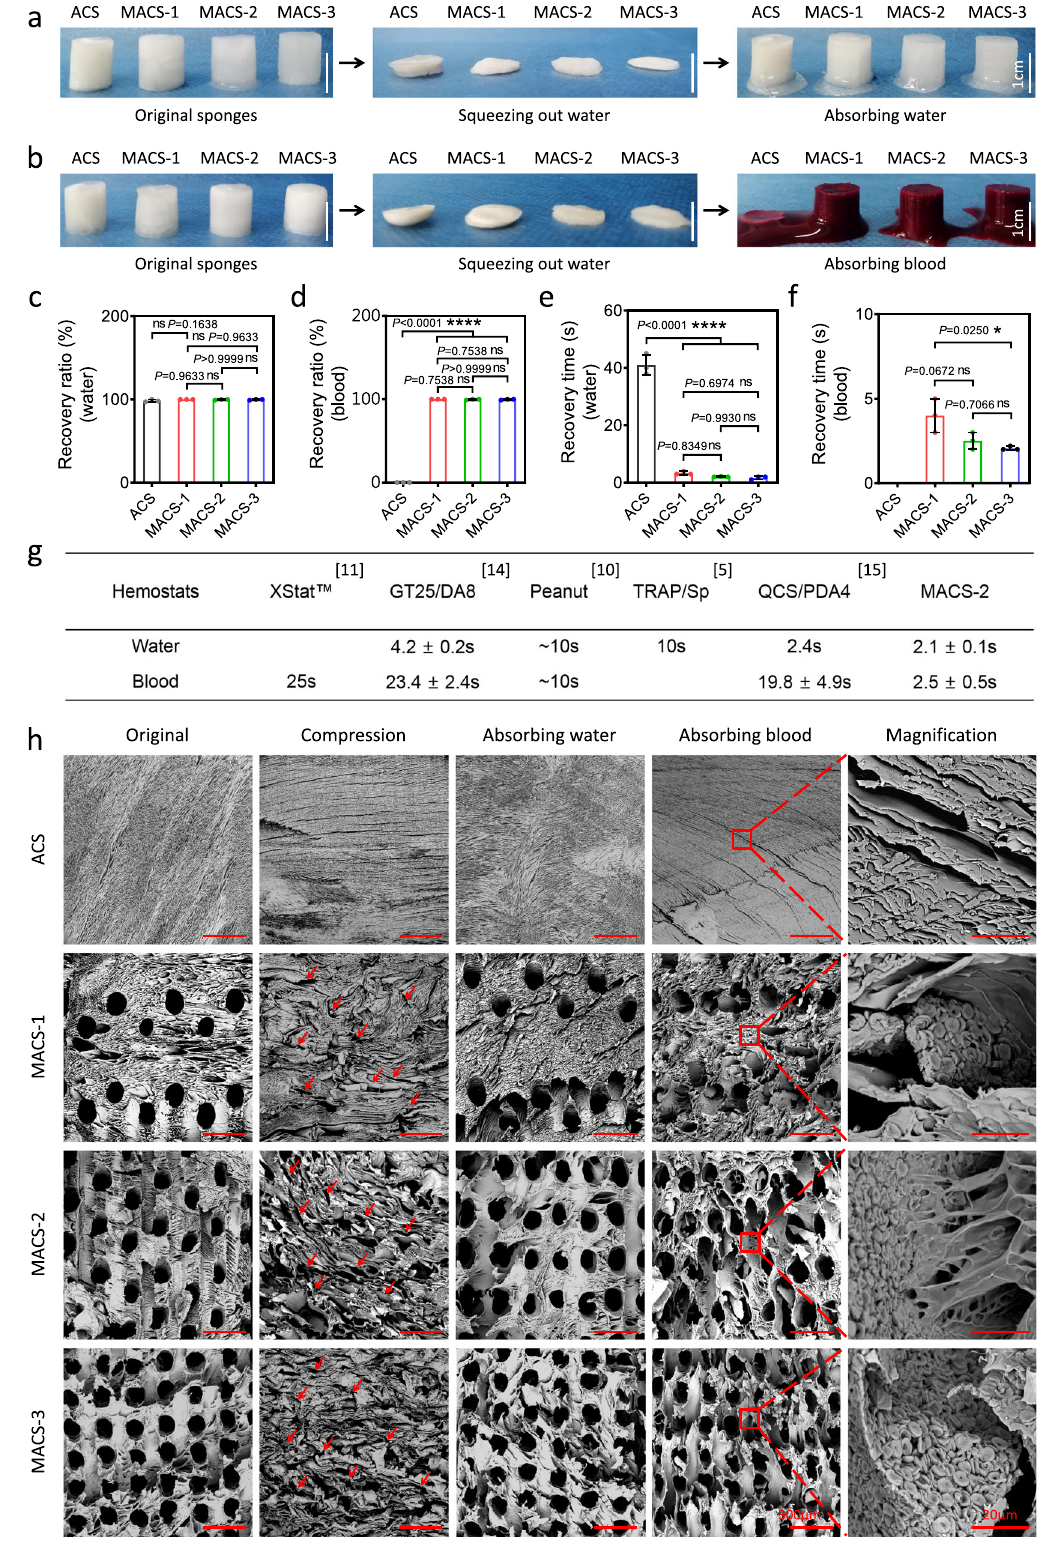
Fig. 4 Shape-memory property of the ACS and MACSs after absorbing water and blood. a, b Macro photographs of the water-triggered and blood- triggered shape recovery of the ACS and MACS-1/2/3. c – f Shape-recovery ratio and time of the compressed sponges. The shape-recovery time of the ACS was not shown as the compressed ACS could not restore to its original shape after absorbing the blood. n = 3 independent samples. Data are expressed as mean ± SD. the signi fi cant difference was detected by one-way ANOVA with Tukey ’ s multiple comparisons test. The ‘ ns ’ indicated no signi fi cant difference, *P < 0.05, ****P < 0.0001. g Comparison of shape-recovery time between the MACS-2 and reported hemostats. h SEM images showing the microstructure of the compressed sponges before and after absorbing water and blood. The red arrow represented the deformed